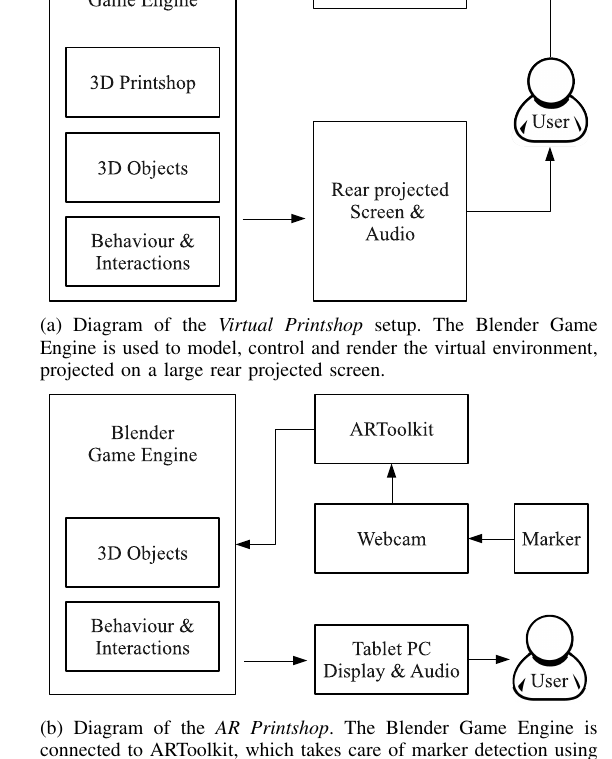
Fig. 3. Diagrams outlining the software used in the two virtual